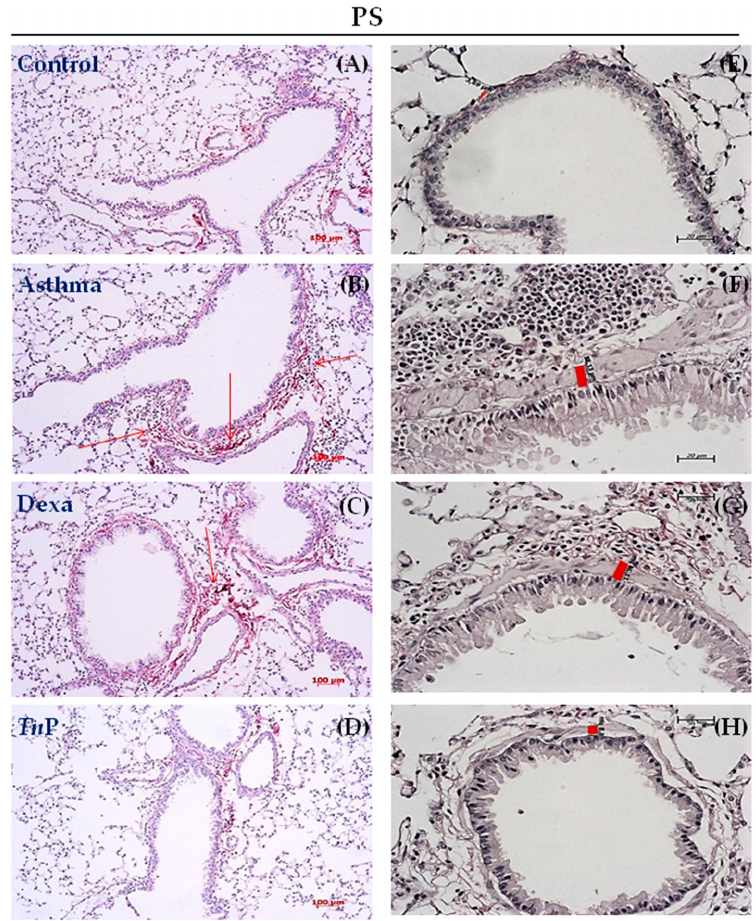
Figure 3. Tn P reduces airway remodeling. Lung sections stained with PS ( A–H ) show the absence of thickness or sub-epithelial collagen deposit in control mice ( A,E ). Sub-epithelial fibrosis ( B,F ) was observed in the asthma group ( B,F ) and Dexa-treated mice ( C,G ), but not in the Tn P-treated mice ( D,H ). The red arrows indicate collagen fibers deposition and red bars indicate